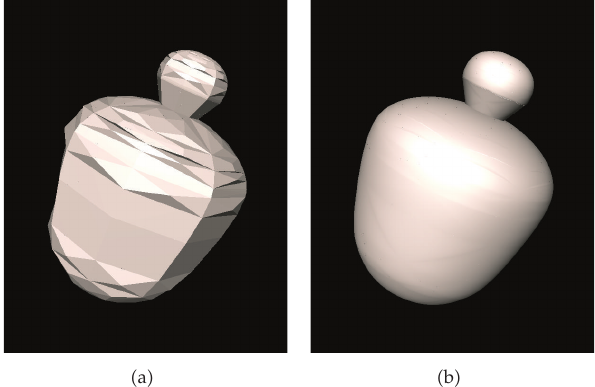
Figure 4: Application of the interpolation to a mesh of a surface with sharp features.